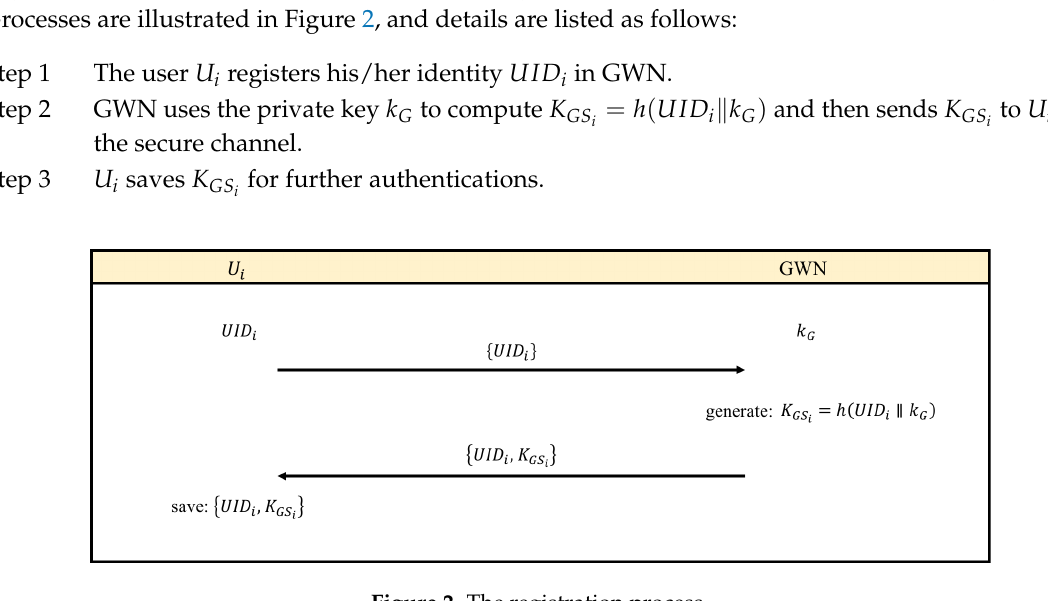
Figure 2. The registration